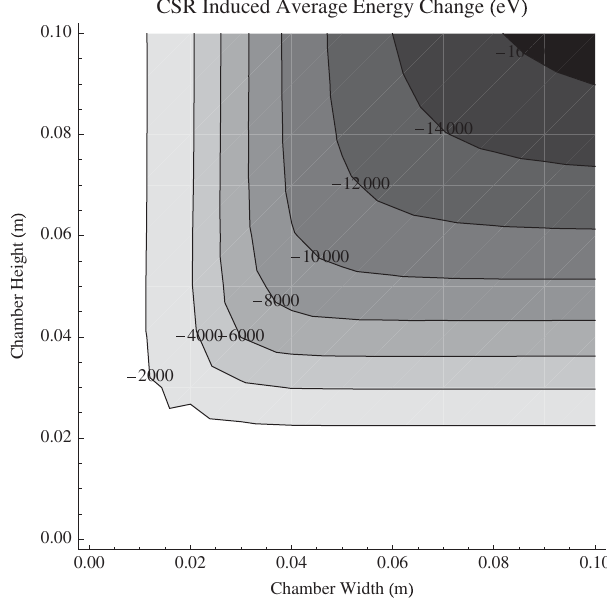
FIG. 22. Numerical results using the A&Y code with varying dimensions of a rectangular chamber. A 1 m, 7.5 (cid:6) bend with a 2 ps long bunch of 0.82 nC charge was used. Contours represent the energy change induced due to the CSR wakefield in 2000 eV increments. The shielding effect is thus primarily due to the smaller of the two beam-pipe